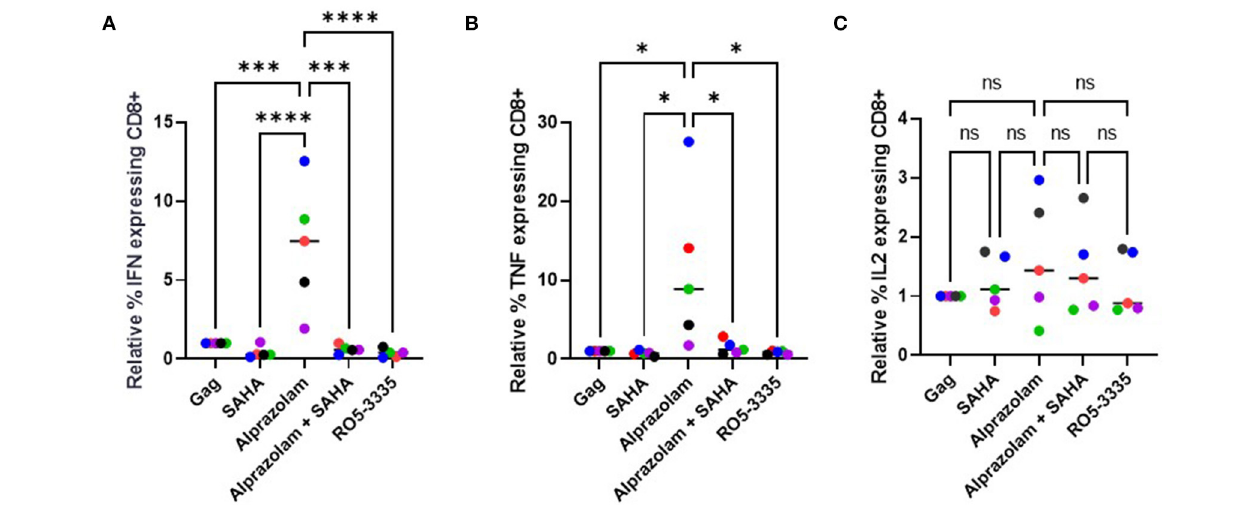
FIGURE 9 | The effect of alprazolam and SAHA on Gag specific CTL response. PBMCs from 5 HIV-1 positive individuals suppressed on therapy were treated with vehicle control, 500nM SAHA, 100nM alprazolam, SAHA plus alprazolam or 100nM Ro5-3335 overnight and then exposed to a set overlapping Gag peptides in the presence of Brefaldin A for 6h. Cells were stained for live/dead marker, CD3, CD4, CD8 and cytokines of interest. The number of (A) IFN γ , (B) TNF α (C) IL-2 expressing CD8 + T-cells for each condition is shown normalized to untreated control. * P ≤ 0.05, *** P ≤ 0.001, **** P ≤ 0.0001, ns = not